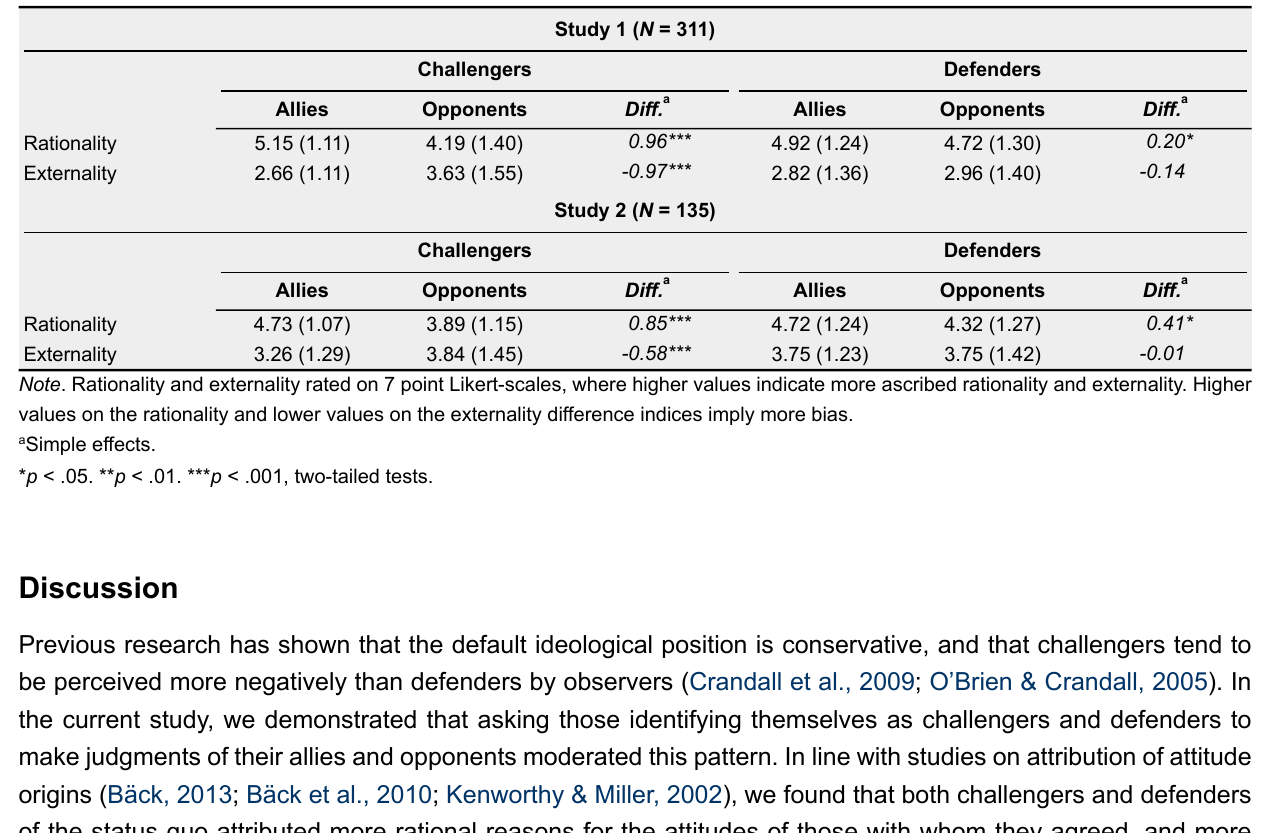
Means and Standard Deviations of Rationality and Externality Ratings for Challengers and Defenders of the Status